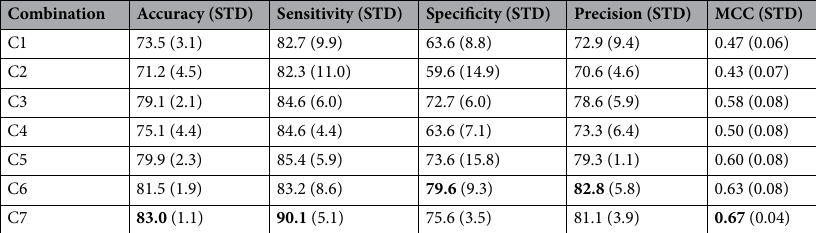
Table 4. Results achieved using fivefold cross validation for ACP-240 dataset for different input feature groups. The STD is also presented in the brackets for each measurement. Bold items indicate the best values found by the methods.